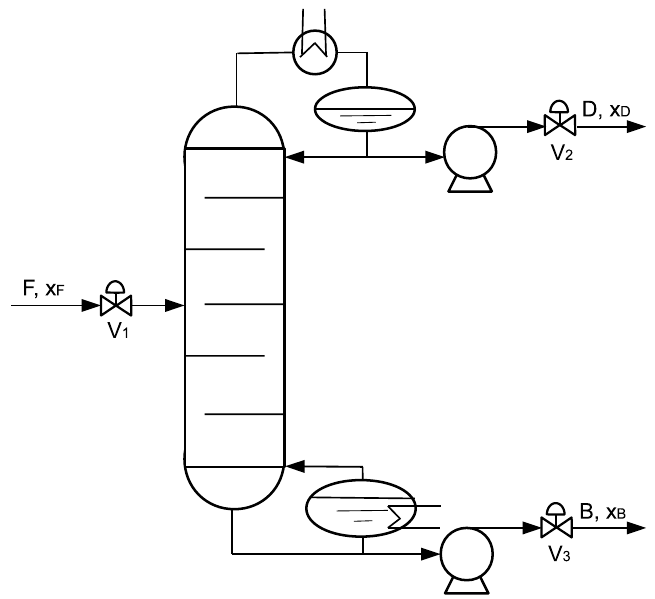
Figure 9. A schematic diagram of the distillation column implemented in Aspen Plus